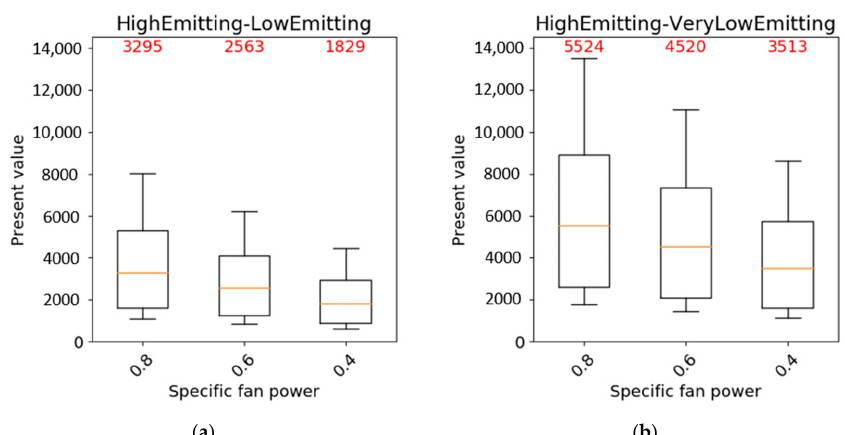
Figure 3. Present values calculated with different specific fan power: the lower this value is, the more efficient the fans are. ( a ) Scenario HE − LE. ( b ) Scenario HE − VLE.